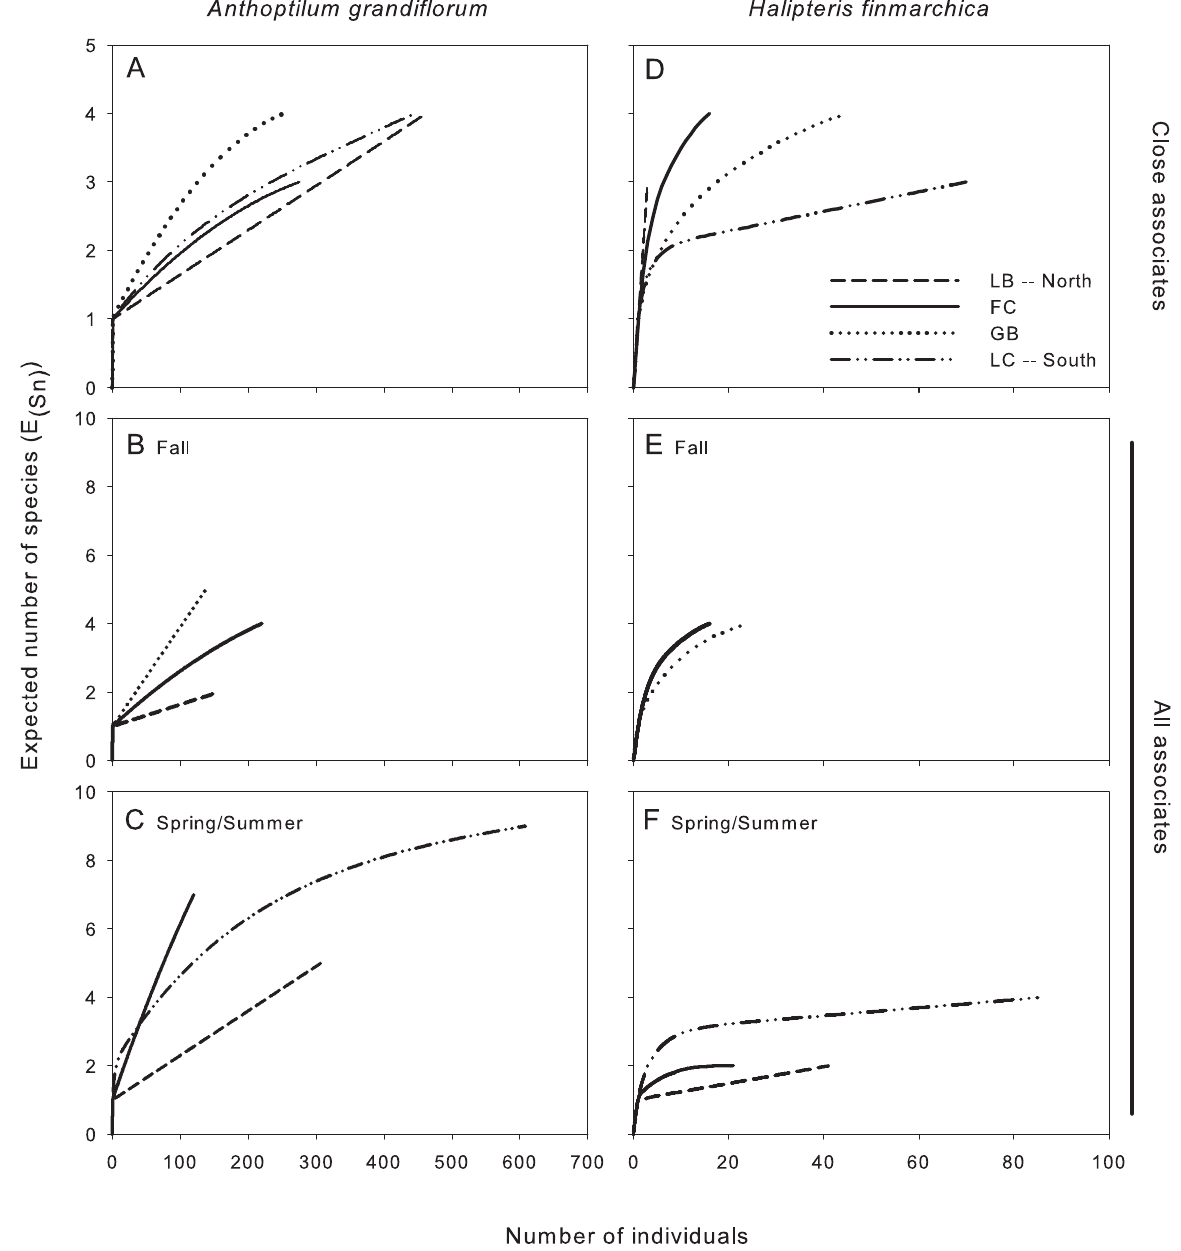
Figure 6. Rarefaction curves for Anthoptilumgrandiflorum (left panels) and Halipterisfinmarchica (right panels), based on close associates only (top two panels) or all associates in spring and fall (bottom four panels). (A) Close associates of A. grandiflorum ; (B) all the associated fauna of A. grandiflorum in the fall and (C) in spring/summer. (D) Close associates of H. finmarchica ; (E) all the associated fauna of H. finmarchica in the fall and (F) in spring/summer. LC: Laurentian Channel, GB: Grand Banks, FC: Flemish Cap, NNL: North Newfoundland, LB: